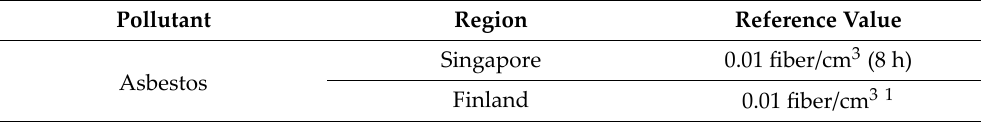
Table 23. Reference value for